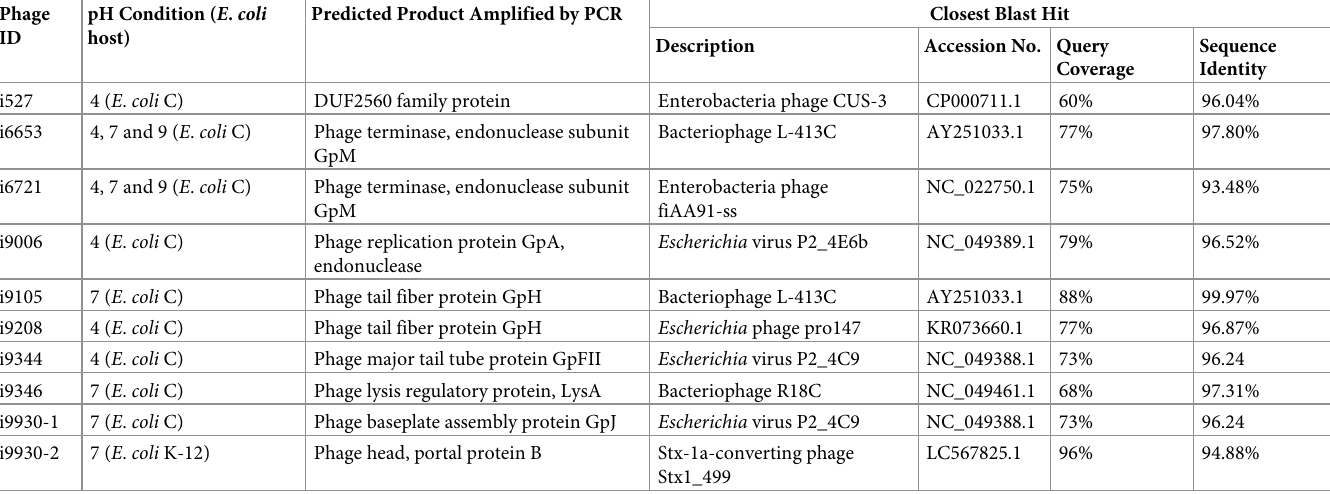
Table 2. pH-induced prophages from urinary E . coli strains and their closest characterized and sequenced phage. Phages are named as i plus the E . coli strain number from which they were induced. As two phages were isolated from E . coli UMB9930, they are signified as “-1” and “-2”. Phage pH Condition ( E . coli ID